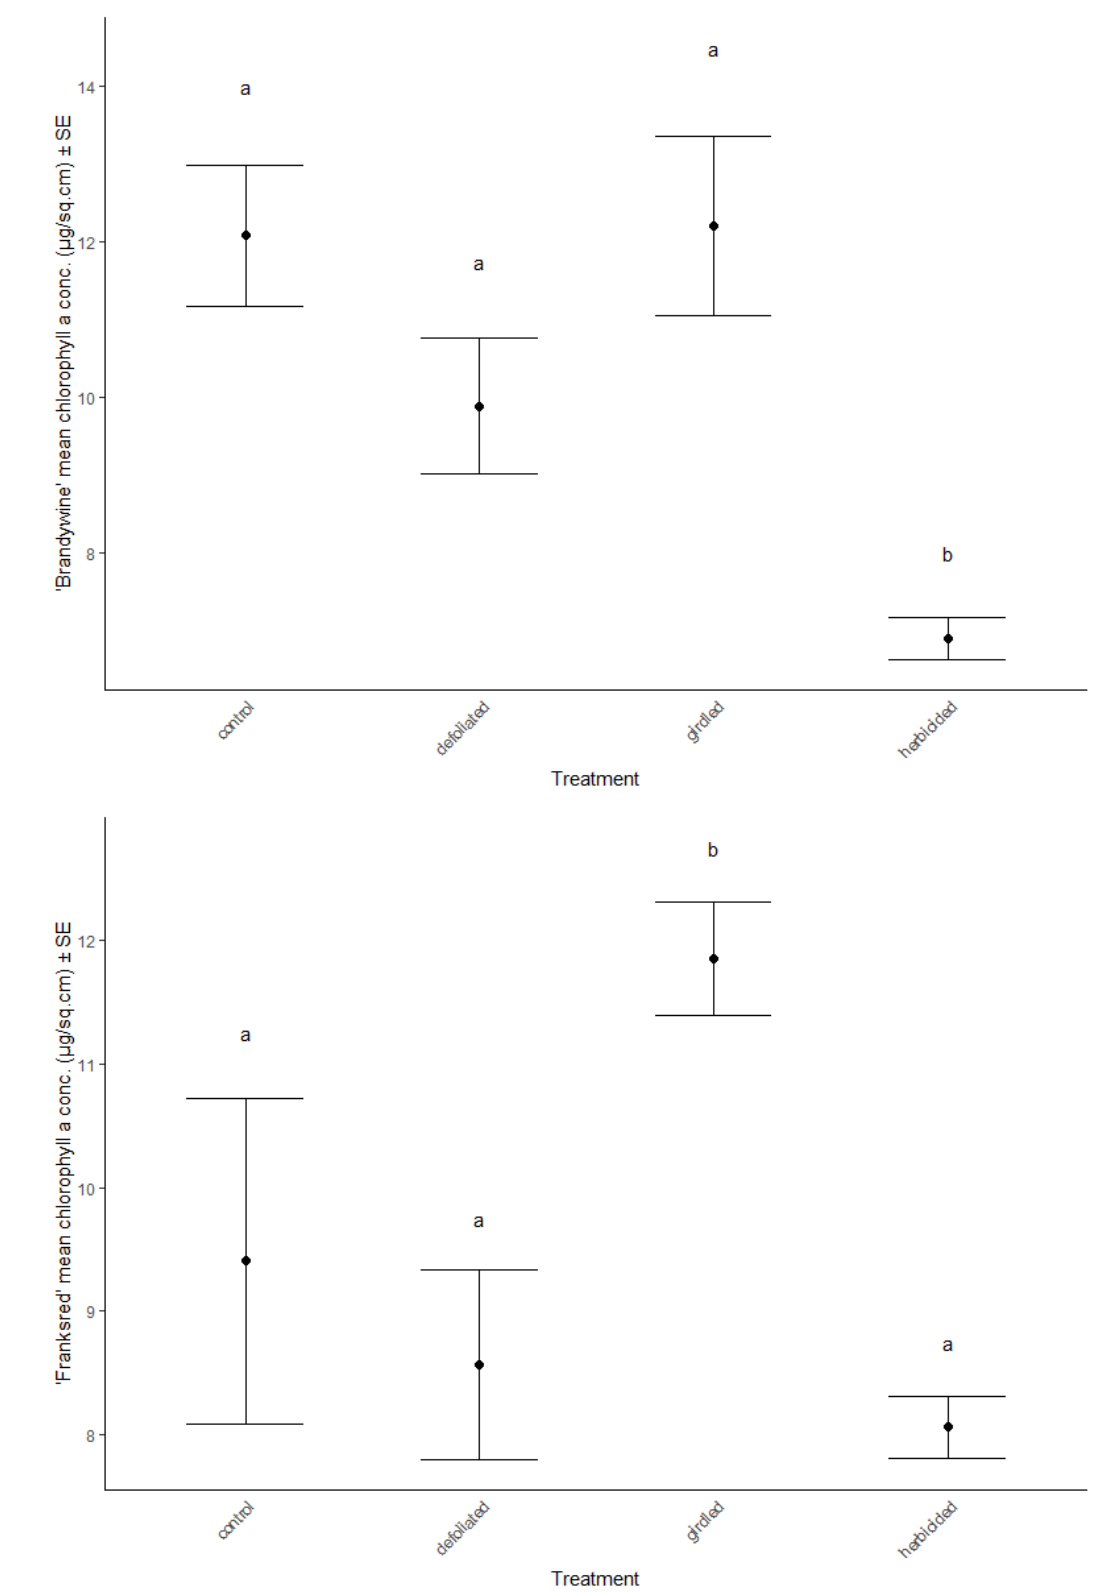
Figure 3. Changes in chlorophyll a concentrations in response to stress treatments in red maple ( Acer rubrum ) cultivars ( a ) ‘Brandywine’ and ( b ) ‘Franksred’. Different letters represent statistical differences between treatments according to a post hoc Tukey HSD analysis.